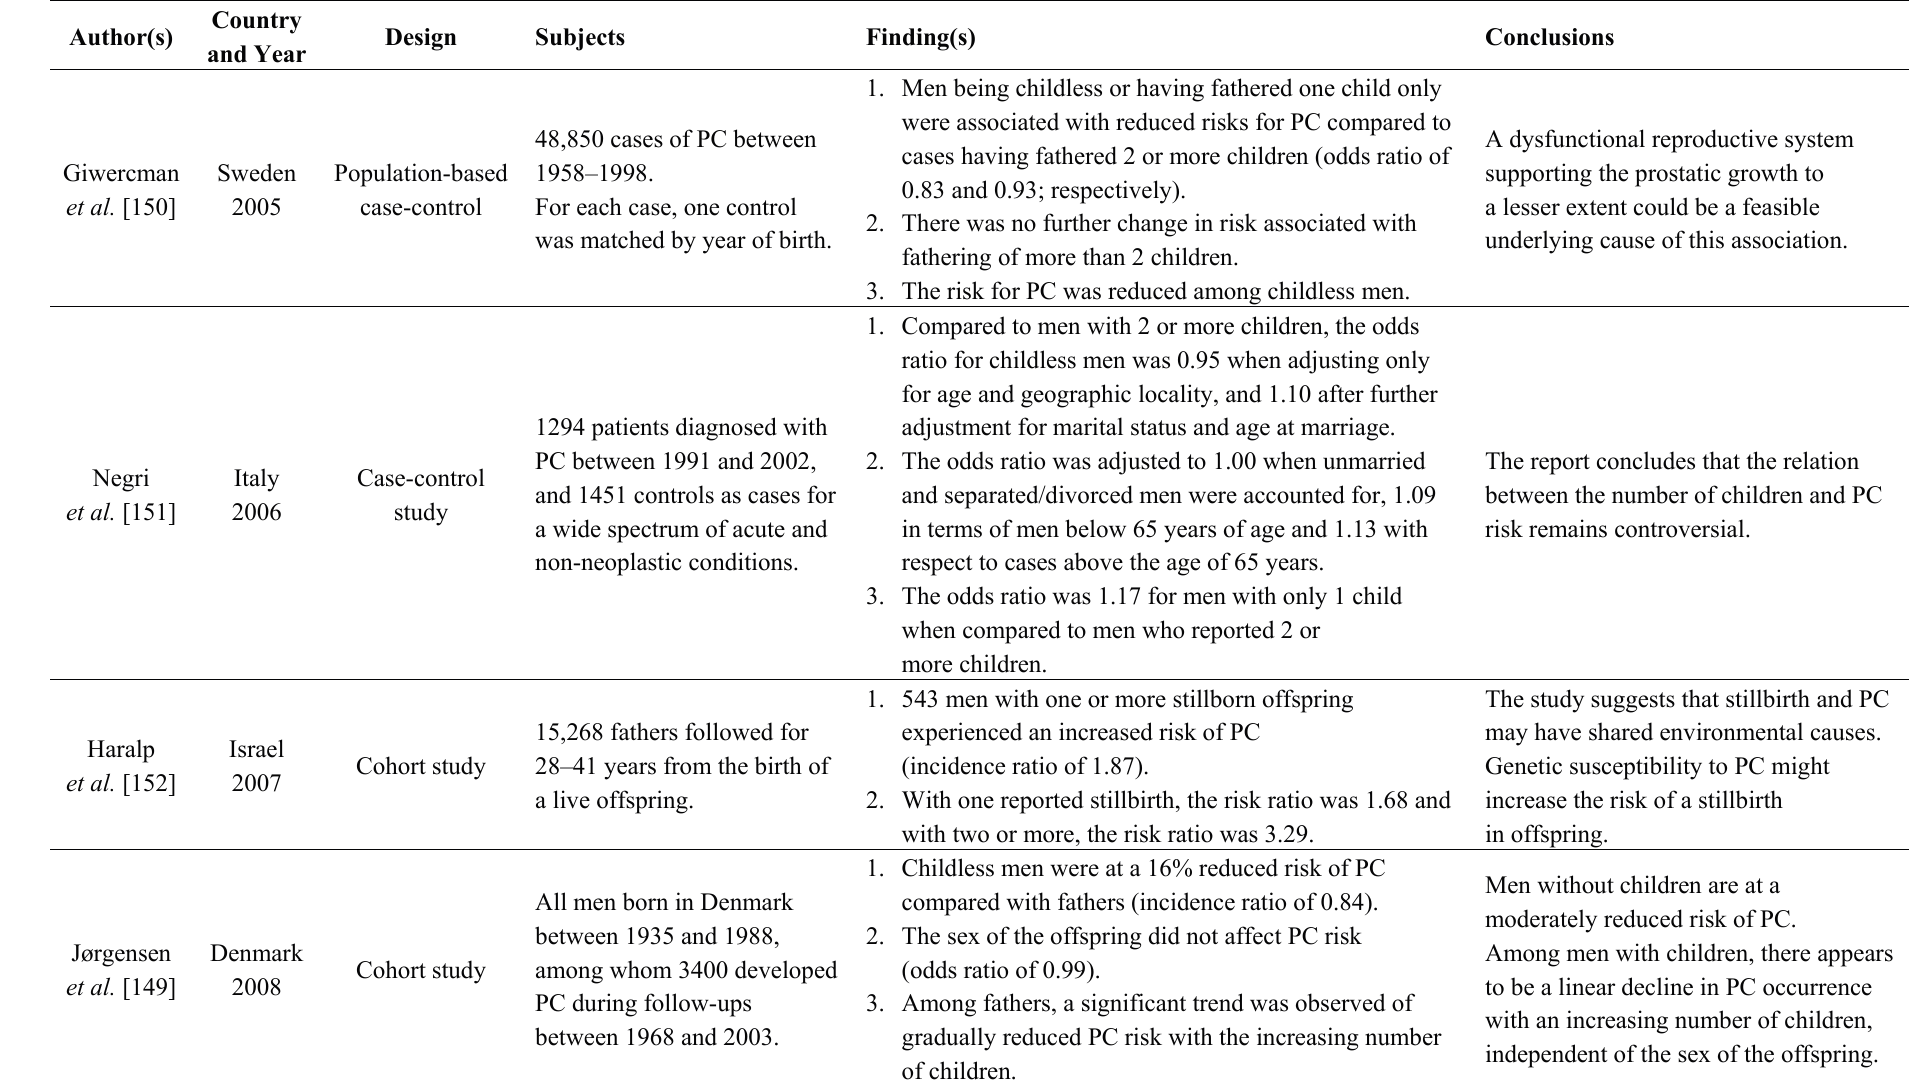
Table 2. Epidemiologic studies of the association between male infertility and prostate